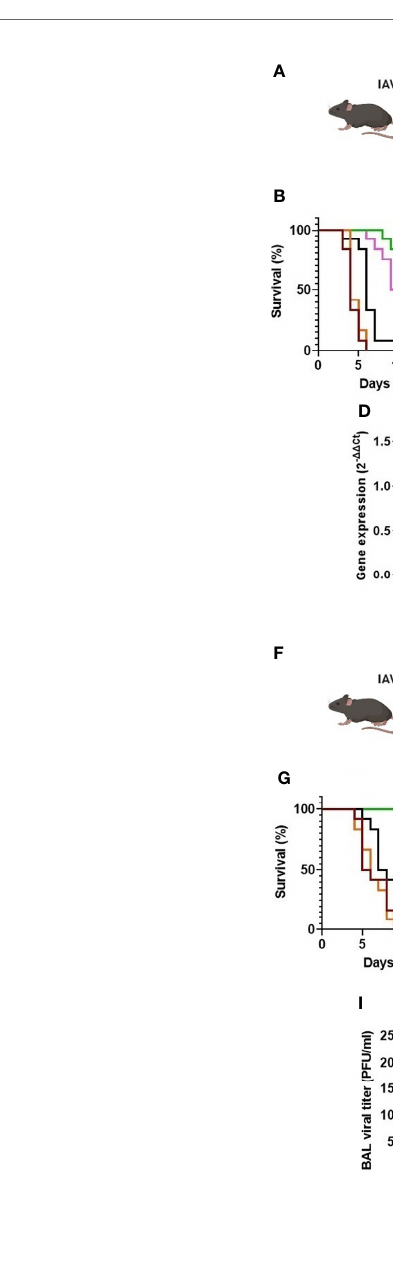
FIGURE 8 | The AMT+OSCN − combination treatment cured mice of lethal H3N2 in fl uenza A virus challenge. (A – E) C57BL/6 mice were infected intranasally with 3,000 PFU of the A/Hong Kong/8/1968 (H3N2) IAV strain. Animals were treated with the indicated antiviral drugs and their combinations for 5 days (2 – 7 dpi) by oral gavage (two doses daily). In the untreated “ placebo ” group, animals received the equivalent volume of distilled water. Animals were observed until 21 dpi. (A) Experimental timeline for panels (A – E) . (B) Mortality was measured and presented as Kaplan – Meier survival curves, and (C) weight changes are presented as percentages of the initial body weight of the animals (6 mice per group, two independent experiments). At 3 dpi, BAL from infected mice treated as indicated was collected, and BAL cells and cell-free supernatants were separated by centrifugation. (D) Viral gene expression in BAL cells was measured by qPCR and normalized on the values of the infected but untreated group. (E) Viral titers in cell-free BAL supernatants were determined by PFU assays. Data are expressed as mean ± SEM of n = 3 independent experiments that each used 3 animals per group. (F – J) Similarly to panels A – E, C57BL/6 mice were infected intranasally with 3,000 PFU of A/HK/1968 (H3N2) IAV. Animals were, however, treated with the indicated antiviral drugs and their combinations for a longer period of time, 10 days (2 – 12 dpi), by oral gavage (two doses daily). In the untreated “ placebo ” group, animals received the equivalent volume of distilled water. Animals were observed until 21 dpi. (F) Experimental timeline for panels (F – J) . (G) Mortality, (H) weight changes, (I) BAL cell viral gene expression, and (J) BAL supernatant viral titers were determined as indicated previously. AMT, amantadine; BALF, bronchoalveolar lavage fl uid; OSCN, hypothiocyanite; OSL, oseltamivir; PFU, plaque-forming unit. *, p < 0.05; ***, p < 0.001; ****, p <